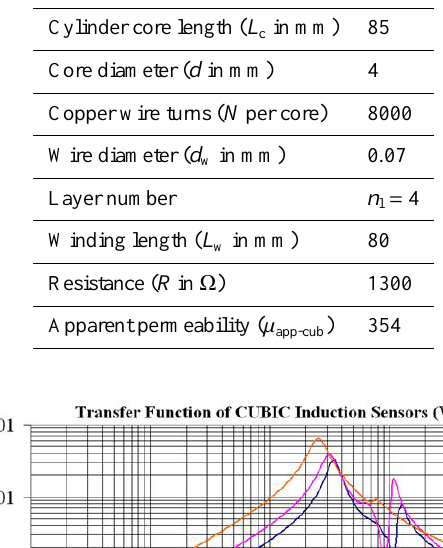
√ (Hz) at 10Hz, assuming e PA = √ (Hz).